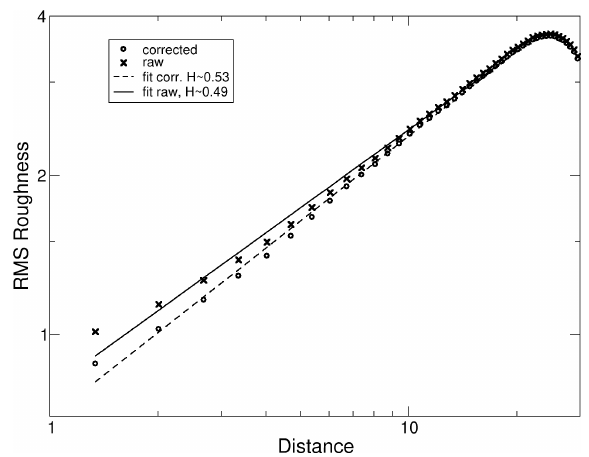
Figure 17. Relation between joint roughness coefficient and Hurst exponent of surfaces from numerical models (squares) and the lime- stone sample (cross). Data points show averages for groups of sur- faces generated under the same stress conditions. Error bars on the limestone data shows anisotropy of the JRC. The dashed line shows the relation proposed by Ficker (2017), Eq.